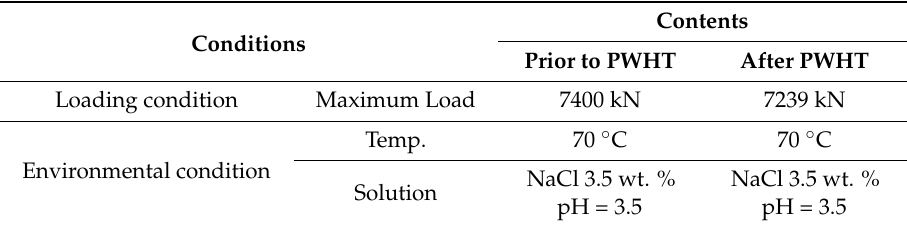
Table 9. Test conditions for corrosion fatigue crack growth rate.